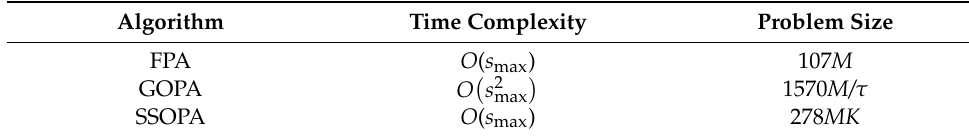
Table 2. Comparison of Algorithm Complexity.